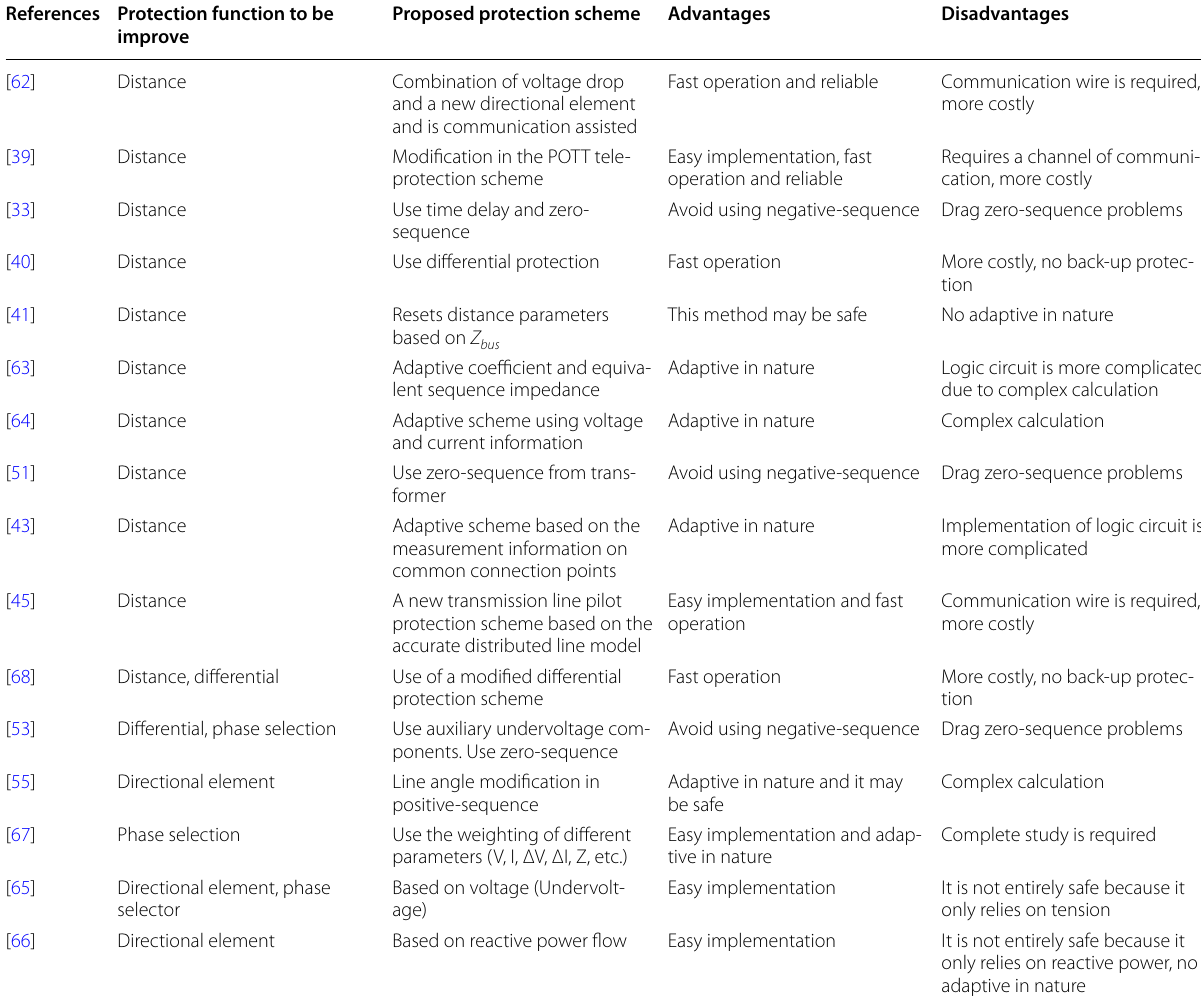
Table 9 Adaptive protection schemes and modification of traditional protection References Protection function to be